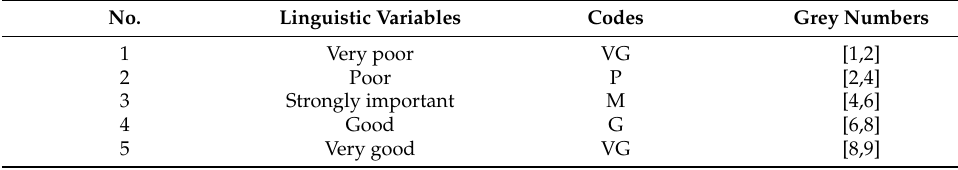
Table 3. The scale for the weighted elements